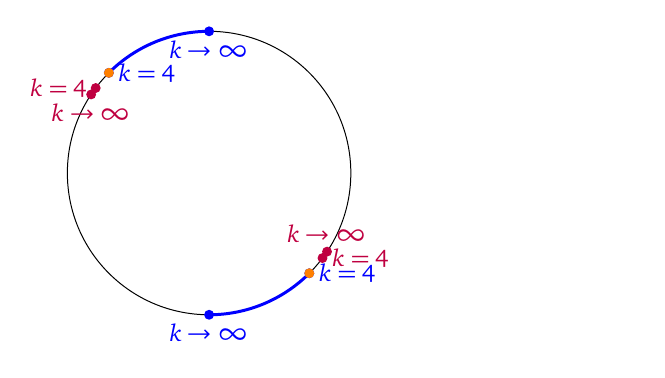
associated with the various integrable points considered 2,1 and π + θ (in red), θ and π + θ (in blue), θ and π + θ (in FZ FZ IK IK TL TL